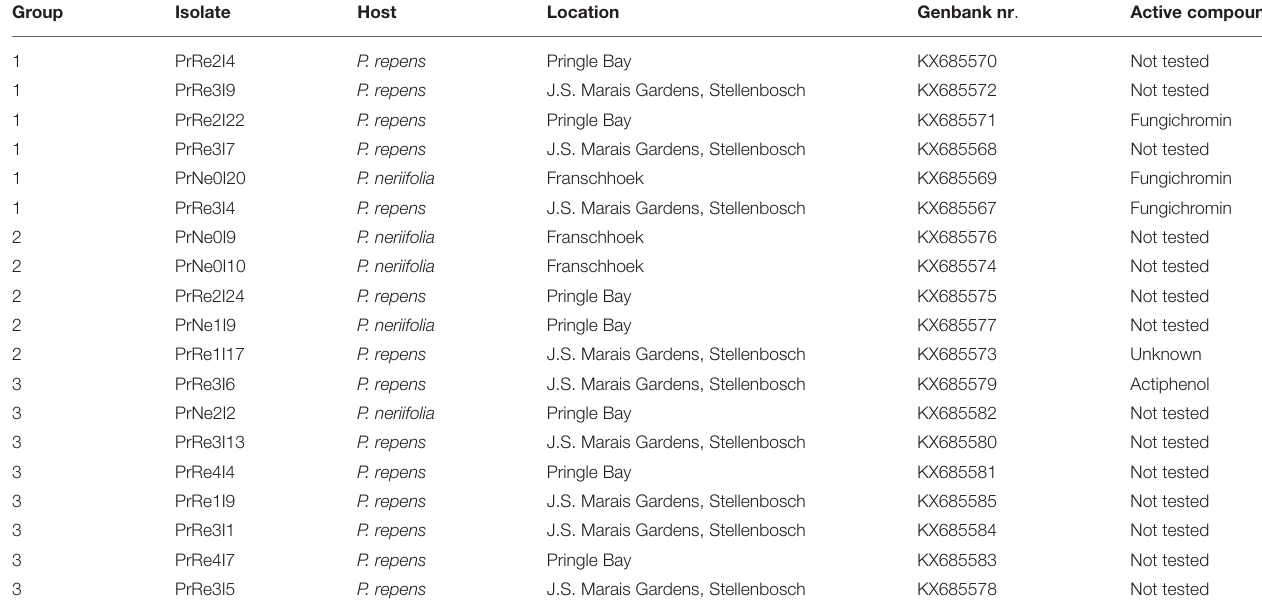
TABLE 1 | Isolates of Streptomyces obtained during the present study, their respective sources, and groupings based on culture morphology and 16S rRNA gene sequences and potential antifungal compounds.